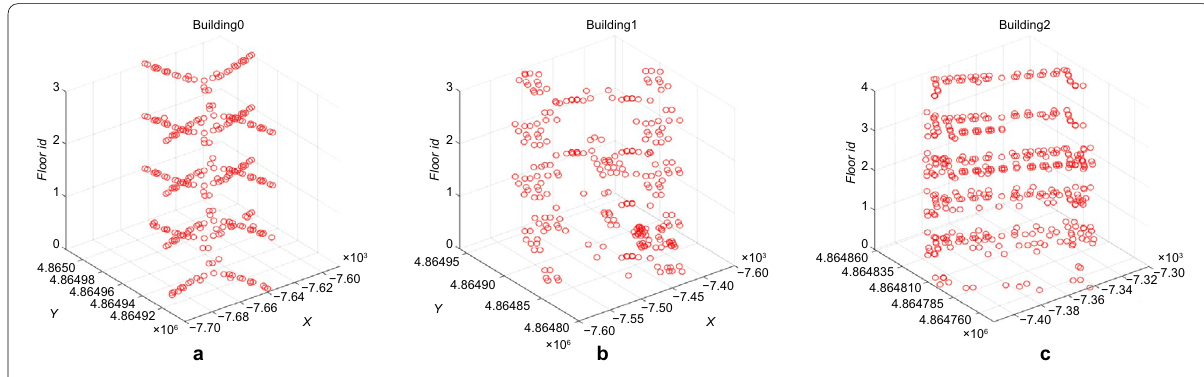
Fig. 5 The fingerprint points’ distribution of each building